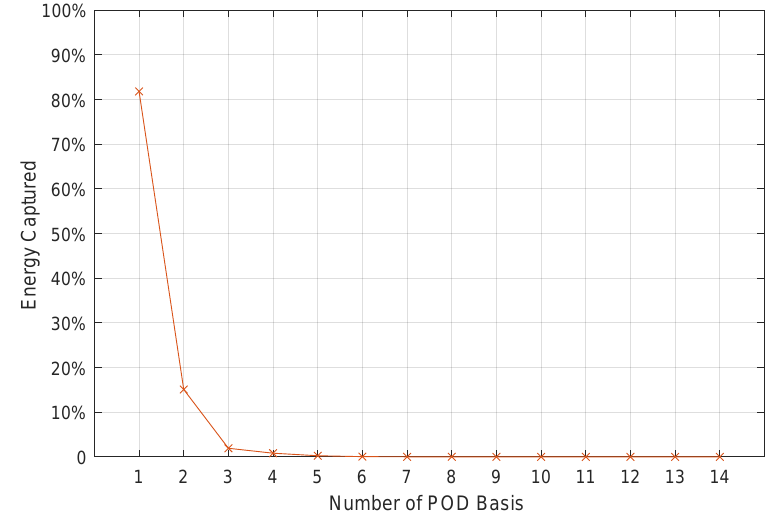
Figure 5. Energy distribution of POD